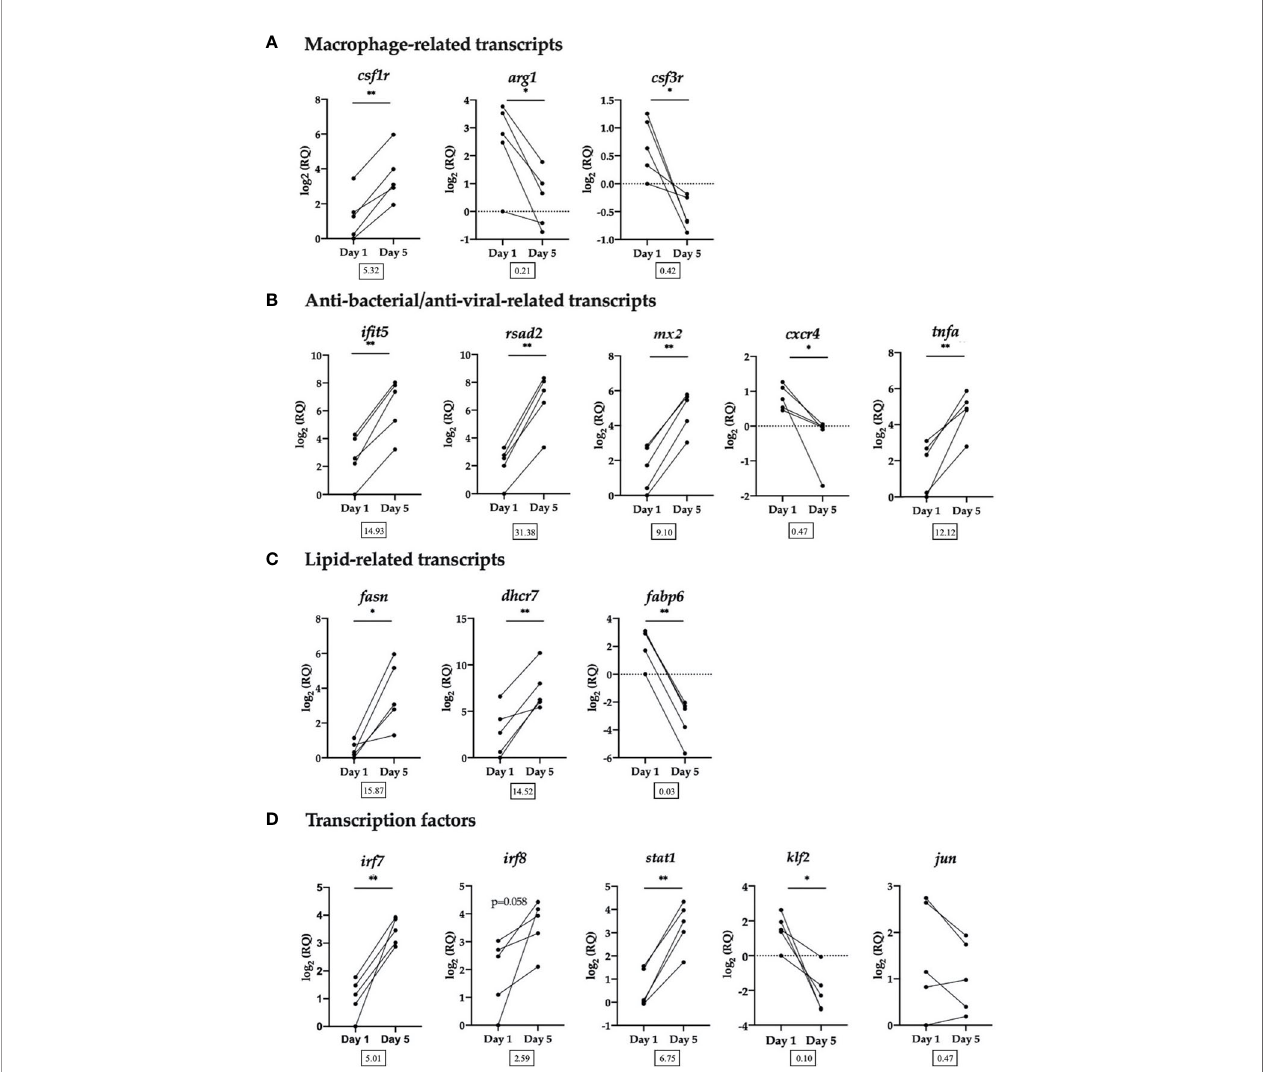
FIGURE 5 | RT-qPCR validation of selected transcripts. (A) Macrophage-related transcripts. Colony-stimulating factor 1 receptor ( csf1r ), arginase-1 ( arg1 ), granulocyte colony-stimulating factor receptor (alias colony stimulating factor 3 receptor ( csf3r)) . (B) Anti-bacterial/anti-viral-related transcripts. Interferon-induced protein with tetratricopeptide repeats 5 ( i fi t5) , radical SAM domain-containing 2 ( rsad2 , alias viperin), interferon-induced GTP-binding protein Mx ( mx2) , C-X-C chemokine receptor type 4 ( cxcr4 ), tumor necrosis factor alpha ( tnfa ). (C) Lipid-related transcripts. Fatty acid synthase ( fasn ), 7-dehydrocholesterol reductase ( dhcr7 ), gastrotropin (alias fatty acid binding protein 6 ( fabp6) ). (D) Transcription factors. Interferon regulatory factor 7 ( irf7 ), interferon regulatory factor 8 ( irf8 ), signal transducer and activator of transcription 1 ( stat1 ), krueppel-like factor 2 ( klf2 ), transcription factor AP-1 (alias jun proto-oncogene ( jun) ). Data from each individual fi sh shown as log 2 (RQ), n = 5, *p < 0.05; **p < 0.01. The number under each fi gure represents the average fold-change in Day 5 HKLs compared to Day 1